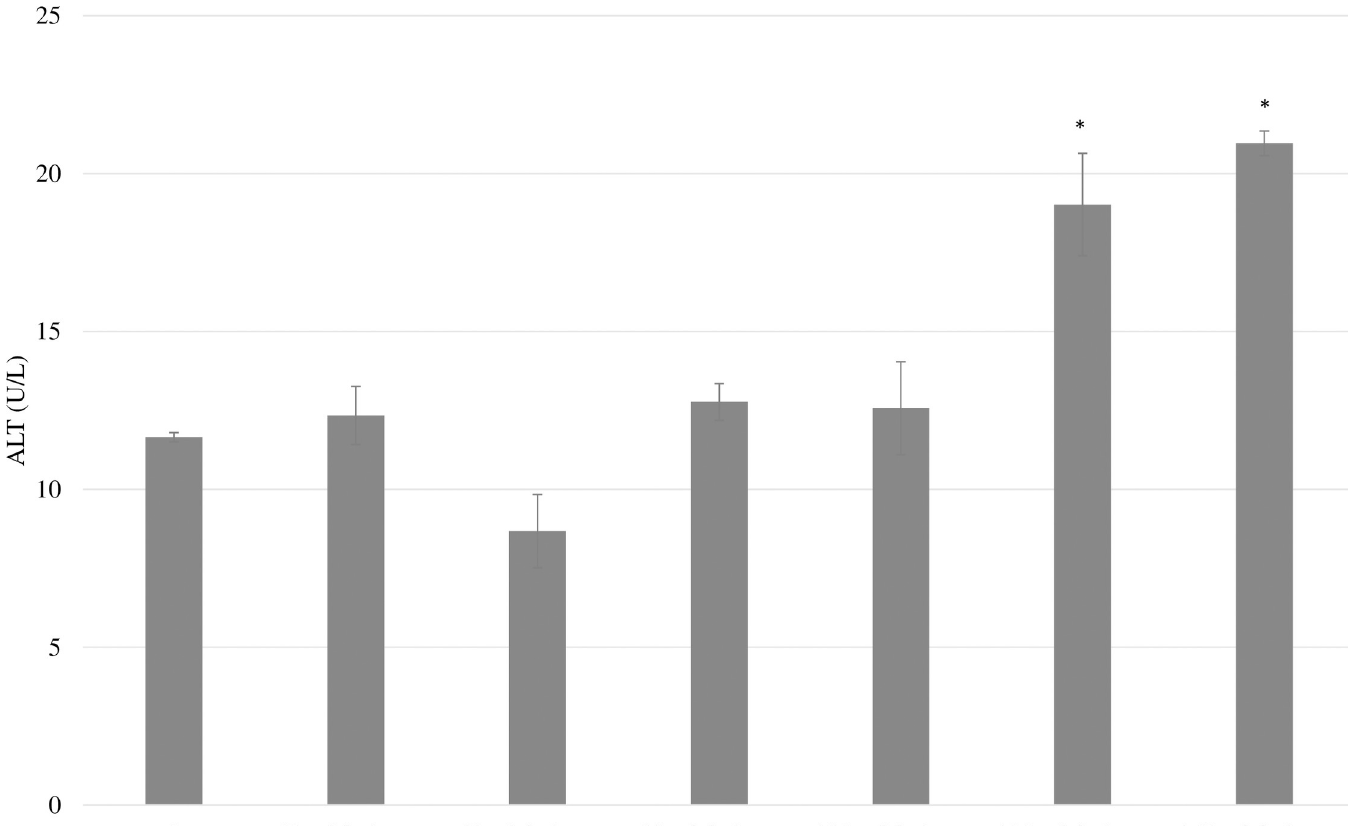
Fig 4. Effect of varying concentrations of glucose on ALT leakage from HepG2 cells. HepG2 cells were exposed to complete DMEM media containing varying concentrations of glucose for 24 hours and the level of transaminase enzyme were measured. Each treatment was done in triplicate and data are expressed as mean ± SEM. � Indicates statistically significant difference at P <